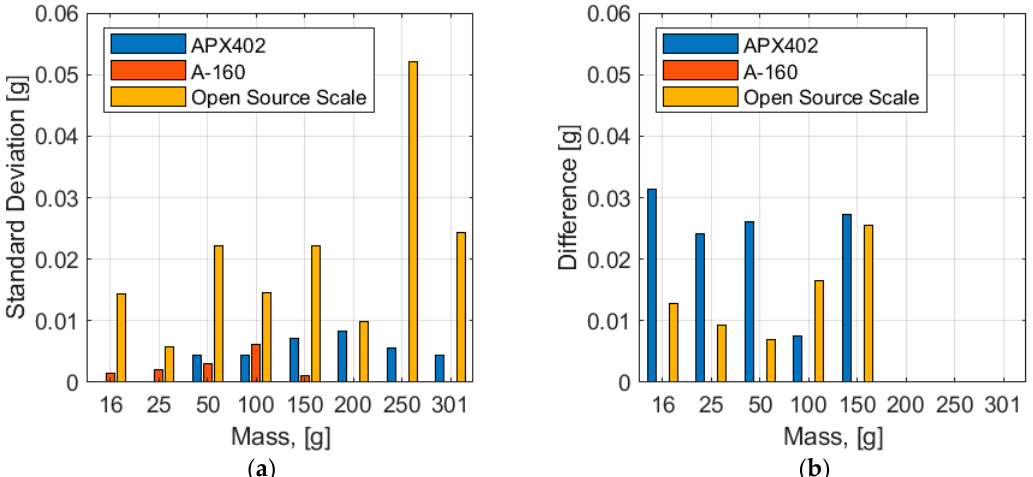
Figure 11. The 500 g load cell test results are shown. ( a ) The standard deviation (sample of 5 measurements) averaged to 0.0207 g for the open-source scale. This is large relative to the lab-grade scales; ( b ) The absolute value of the difference between the average measurements by the A-160 and the other two scales are shown. The open-source scale average measurement was within 0.0142 g of the A-160, on average.